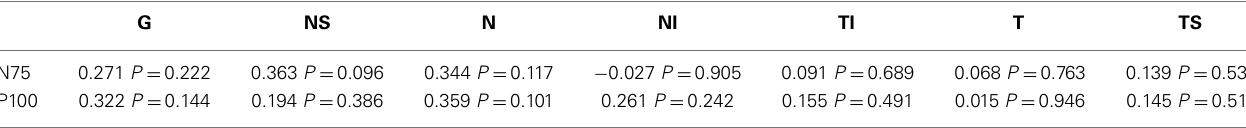
Table 1 | Correlation of N75 and P100 latencies with the RNFLT of the different sectors. G NS